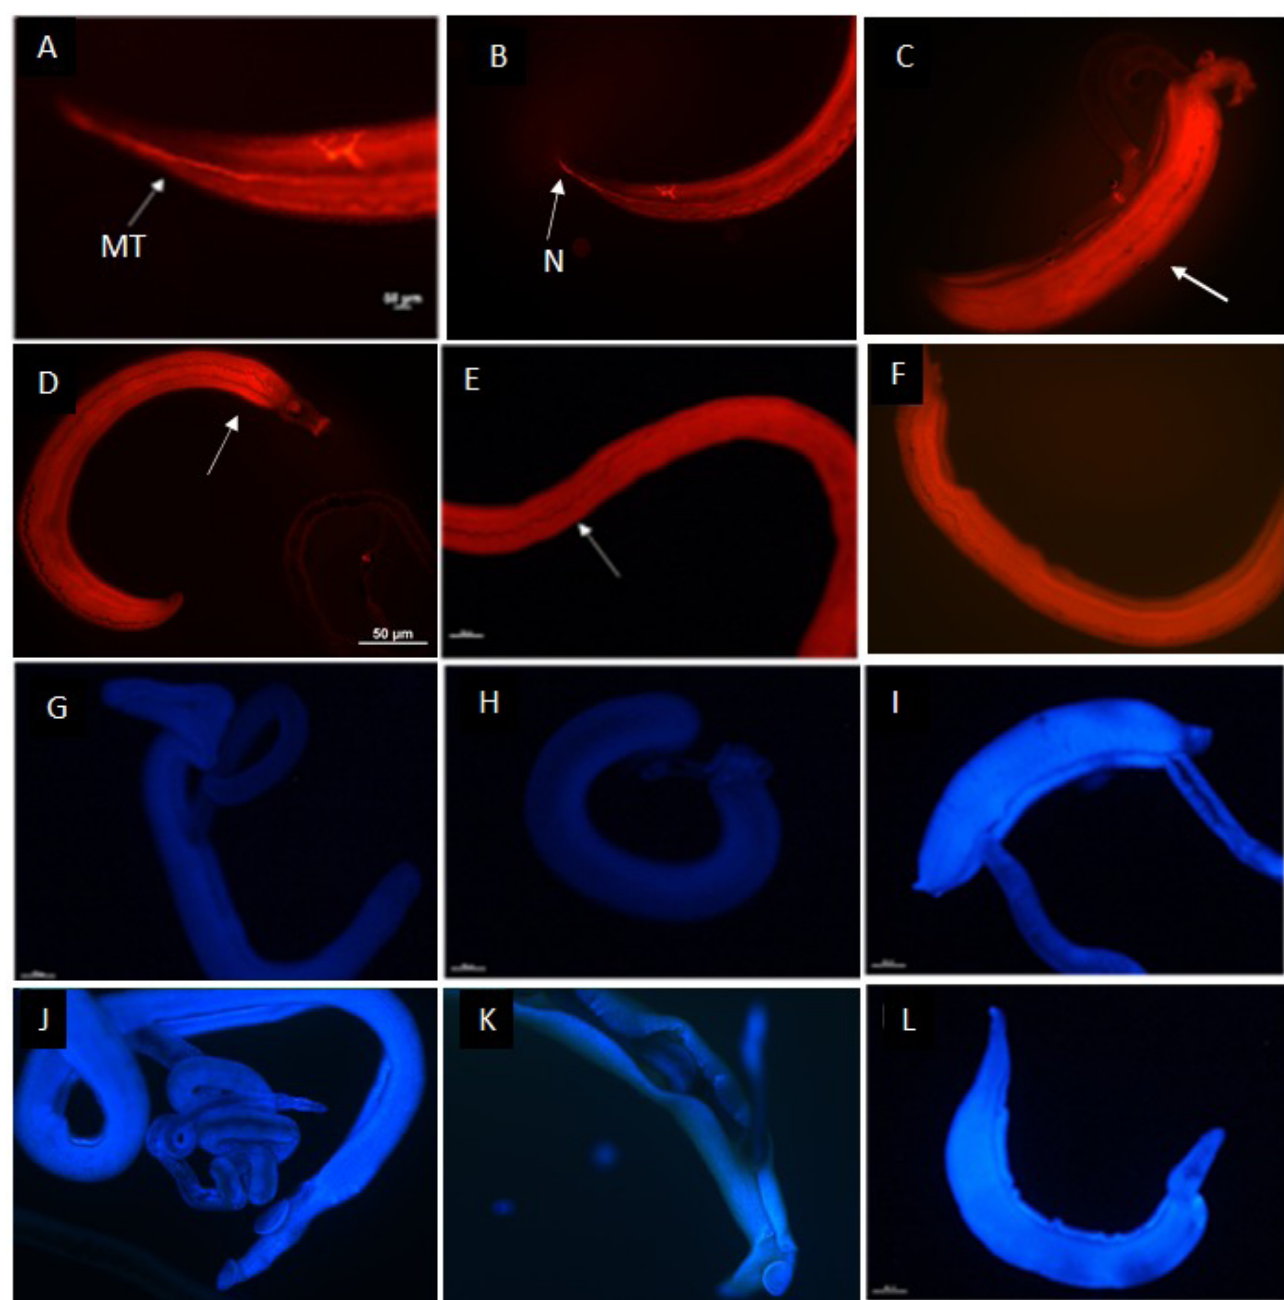
Figure 4. (A-F) Resorufin marking showing damage to the excretory system of Schistosoma mansoni adult worms by eugenol derivatives. (G-L) In addition, the marking of tegument lesions in S. mansoni adult worms by the Hoechst 33258 probe is shown. (A) Adult male worm exposed to RPMI-1640 (negative control) with fluorescent labelling, indicating a normally functioning excretory system. Arrow: main tubule (MT). (B) An adult female worm incubated with methanol diluent, indicating a normally functioning excretory system, nephridiopore (N), and ramifications of the excretory system. (C) Couple of worms exposed to PZQ (pharmacological control). (D) Male exposed to 0.312 mM of FB1. (E) Female exposed to 0.161 mM of FB4. (F) Male exposed to 0.338 mM of FB9. (C, D, E, F) Fluorescent labelling diffused throughout the body of the parasite, indicating that the excretory system is not working due to the action of the substances (as shown in the arrows). (G) A pair of worms incubated with RPMI-1640 culture medium. (H) A pair of worms incubated with methanol diluent. (I) A pair of worms exposed to PZQ worms showing fluorescent labelling throughout. (J) Adult male worm exposed to 0.312 mM of FB1. (K) A pair of worms exposed to 0.161 mM of FB4. (L) A male worm exposed to 0.338 mM of FB9. (I, J, K, L) The fluorescent areas indicate intense